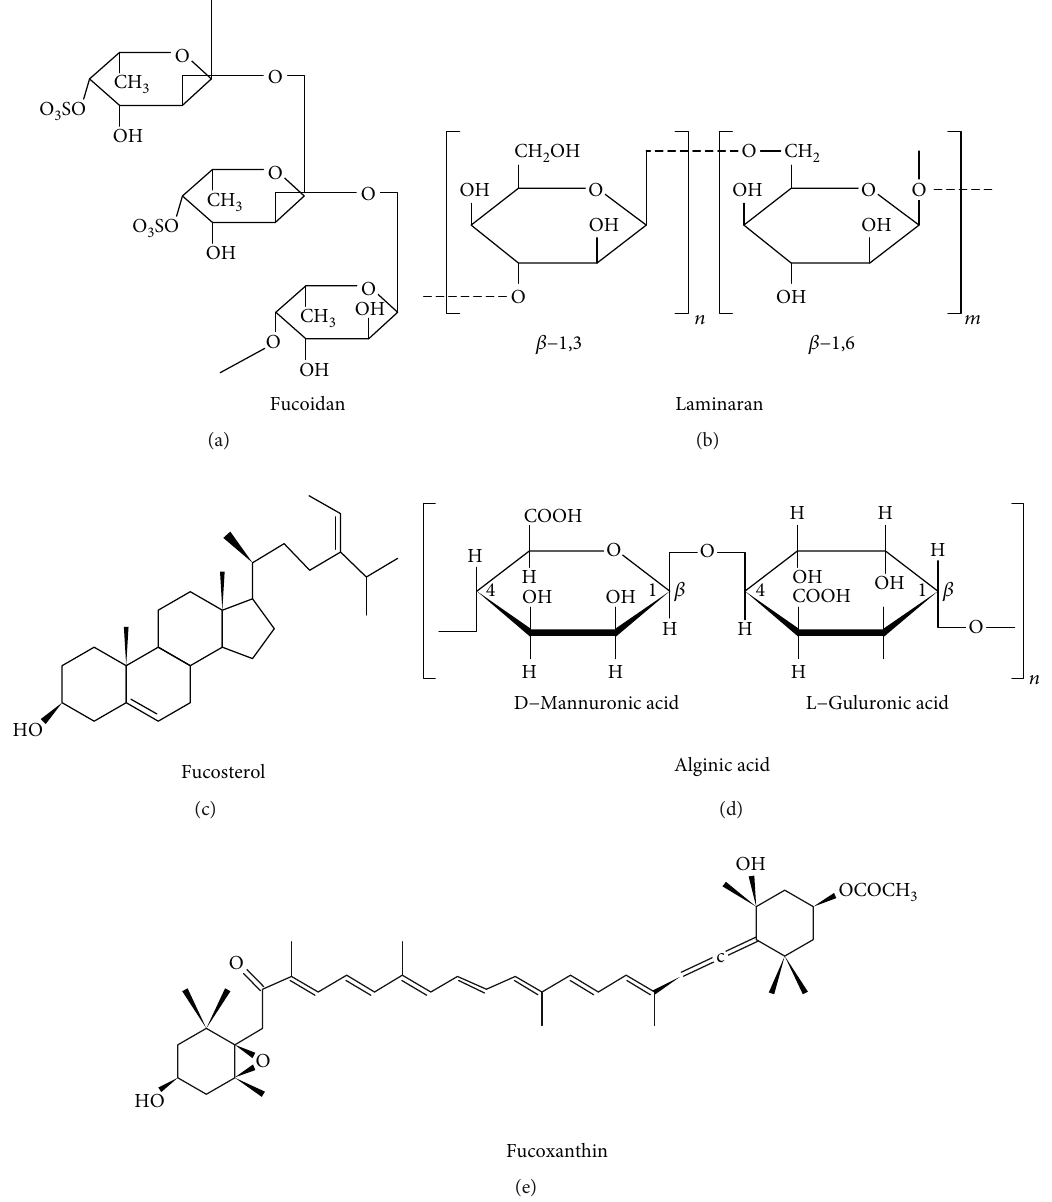
Figure 3: Structural unit of (a) fucoidan, (b) laminaran, (c) alginic acid, (d) fucosterol, and (e)